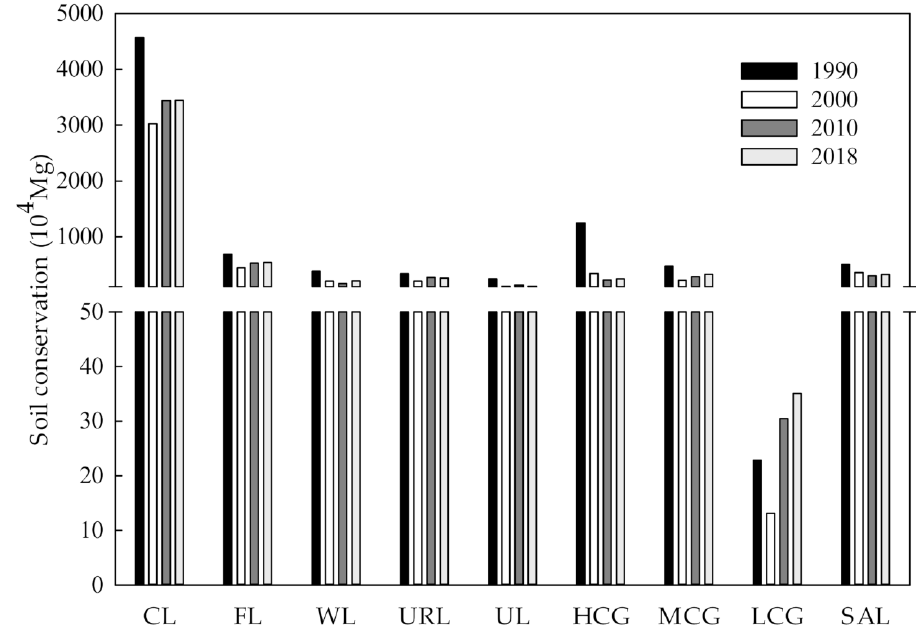
Figure 5. Total amount of soil conservation for different land use types from 1990 to 2018. CL, Culti- vated land; FL, Forest land; WL, Water land; URL, Urban and rural construction land; UL, Unused land; HCG, High-cover grassland; MCG, Medium-cover grassland; LCG, Low-cover grassland; SAL, Saline-alkali